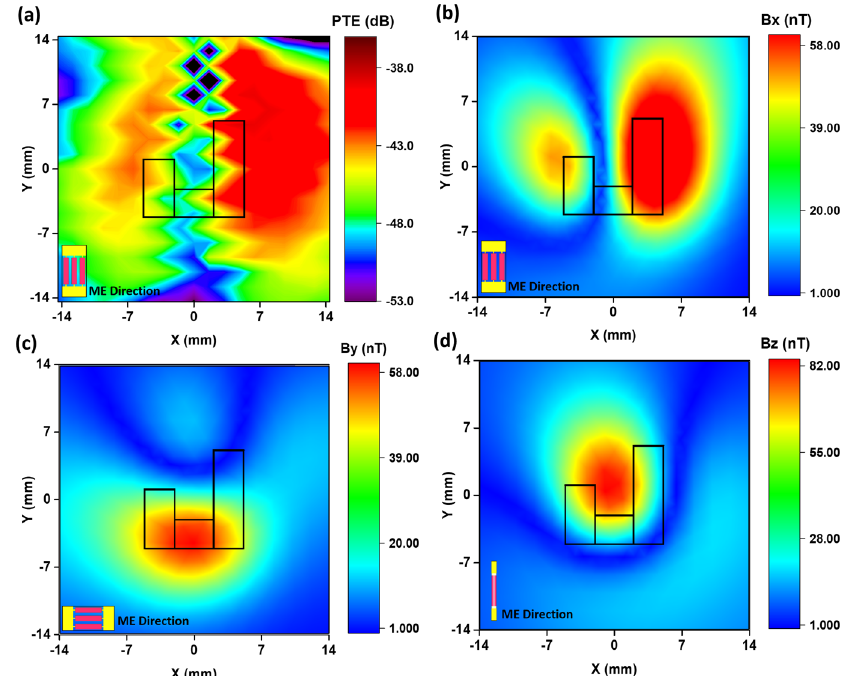
Fig. 3 COMSOL simulation of the ME antenna and the Tx coil misalignment. a Measured PTE of the ME antenna in the XY plane at a fi xed distance of z = 8 mm from the Tx coil. The black fi gure inside the plot shows the coordinate of the Tx coil in the XY plane; b COMSOL simulation results of magnetic fl ux (Bx) in the XY plane at z = 8 mm distance from the coil. The simulation results con fi rm the PTE measurements and show that the longer PCB trace on the right side of Tx coil produces a much larger (> 11×) magnetic fl ux focal point than the shorter trace on the left; c and d show the magnetic fl ux densities By and Bz in the XY plane at z = 8 mm distance from the Tx coil, respectively. The magnetic fl ux By reaches a maximum above the lower copper trace because the current is fl owing along the X axis in this direction. The magnetic fl ux Bz is peaking at the center of the Tx coil because the fi eld loops from copper traces are constructively interfering and giving a fi eld stronger than Bx and